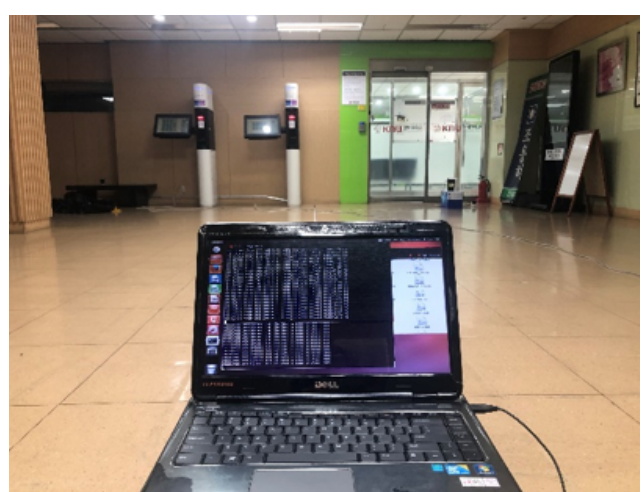
Figure 7. Indoor experiment environment at the 2rd floor of IT-2